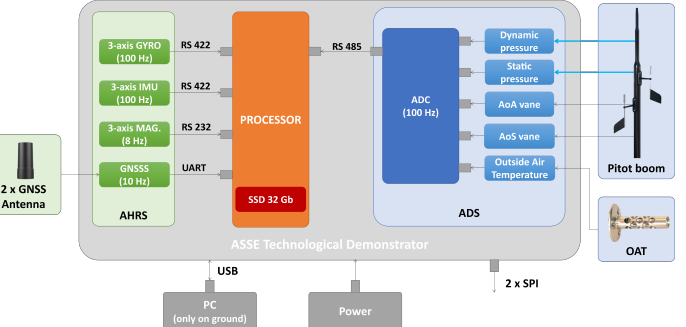
Figure 3. The architecture of the ASSE technological demonstrator. The black arrows represent data bus connections, the blue arrows represent pneumatic